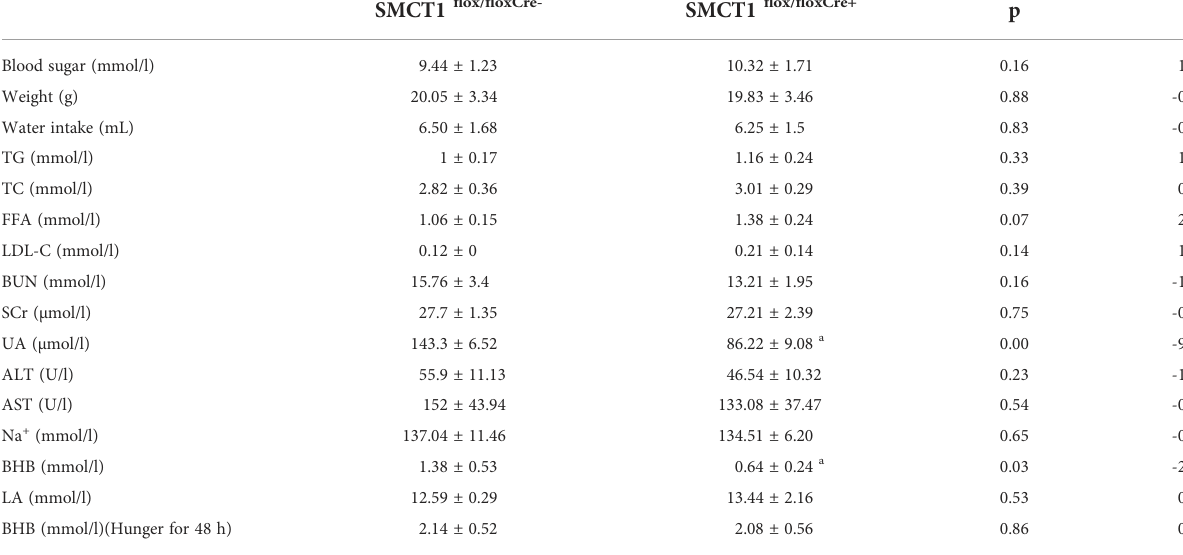
TABLE 2 Baseline general data and plasma biochemical data between the two